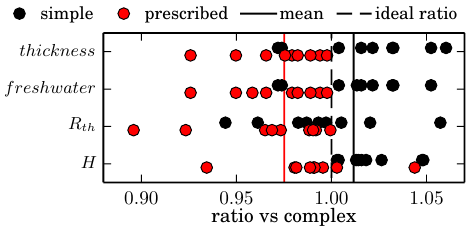
Figure 17. Time-integrated absolute differences of the ice thick- ness, freshwater column, thermal resistance R th , and enthalpy H of simulations using the simple and prescribed SAMSIM salinity approach compared to simulations using the complex approach (de- tails in Sect. 5). The absolute differences were calculated separately for each of the nine reanalysis forced simulations over 4.5 years. Each dot shows the ratio of a specific simulation, while the lines show the mean overall runs and